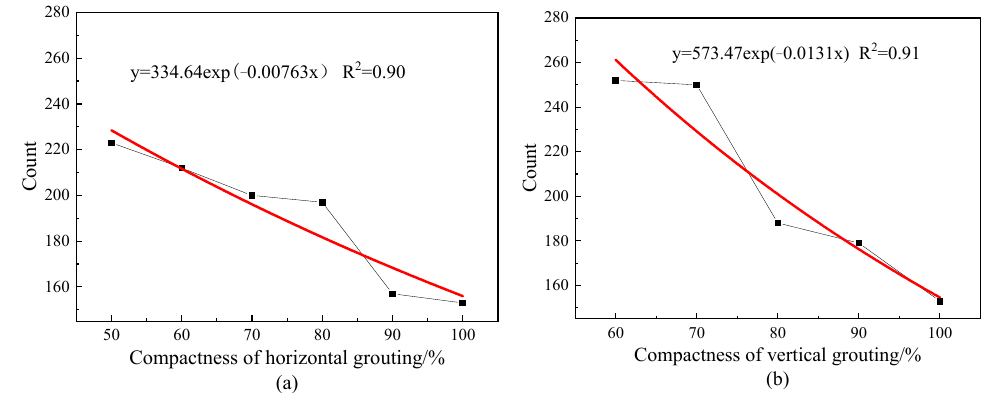
Figure 8. The counts of acoustic emission signals with different grout saturation.